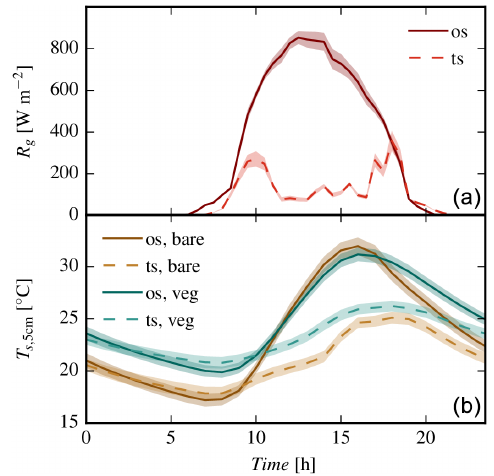
Figure 1. Daily cycles, averaged over the experiment period, of (a) global radiation R g at 1.5m height and (b) soil temperature T S , 5 cm at 5cm depth under bare soil (bare) or vegetation cover (veg). Observations at open sites between tree crowns (os) and shaded sites beneath tree crowns (ts) are shown. Uncertainty bands display standard